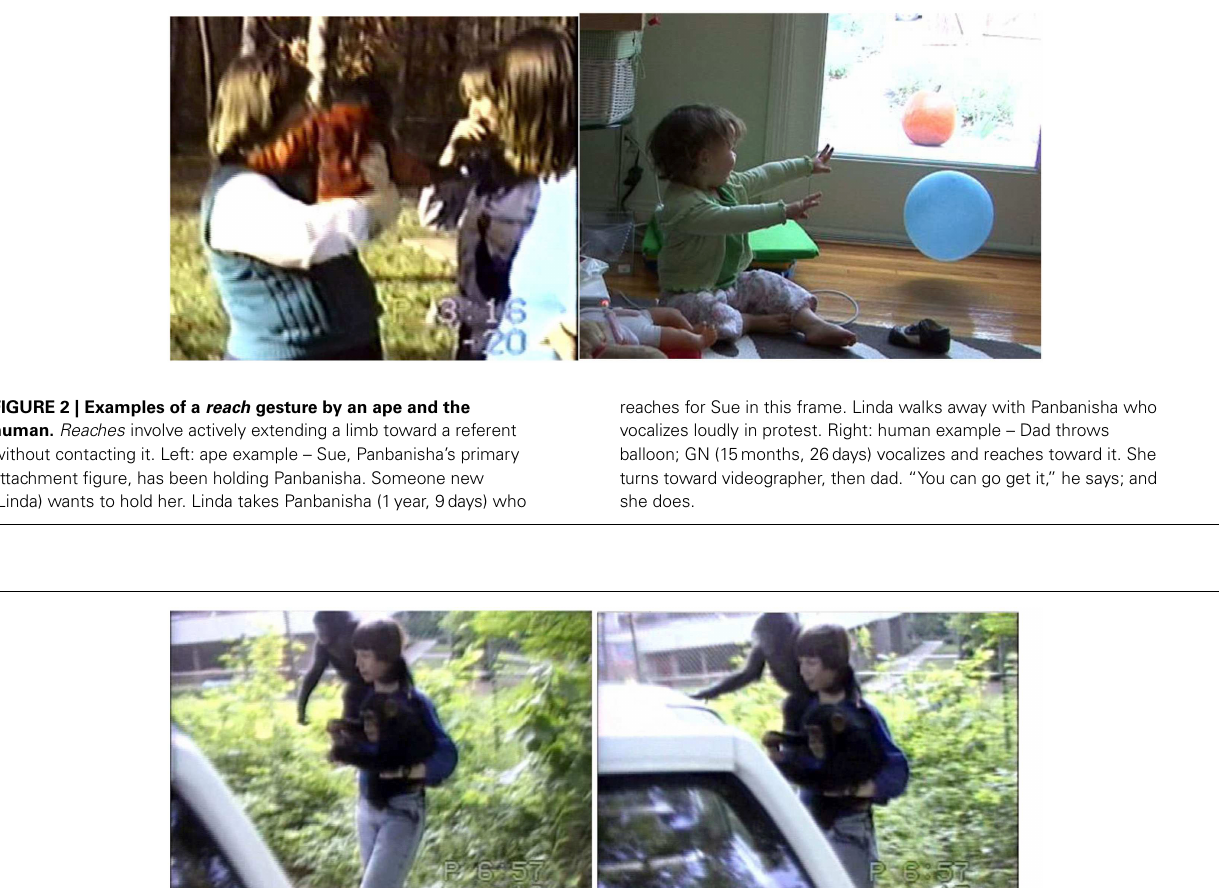
FIGURE 2 | Examples of a reach gesture by an ape and the human. Reaches involve actively extending a limb toward a referent without contacting it. Left: ape example – Sue, Panbanisha’s primary attachment figure, has been holding Panbanisha. Someone new (Linda) wants to hold her. Linda takes Panbanisha (1year, 9days) who